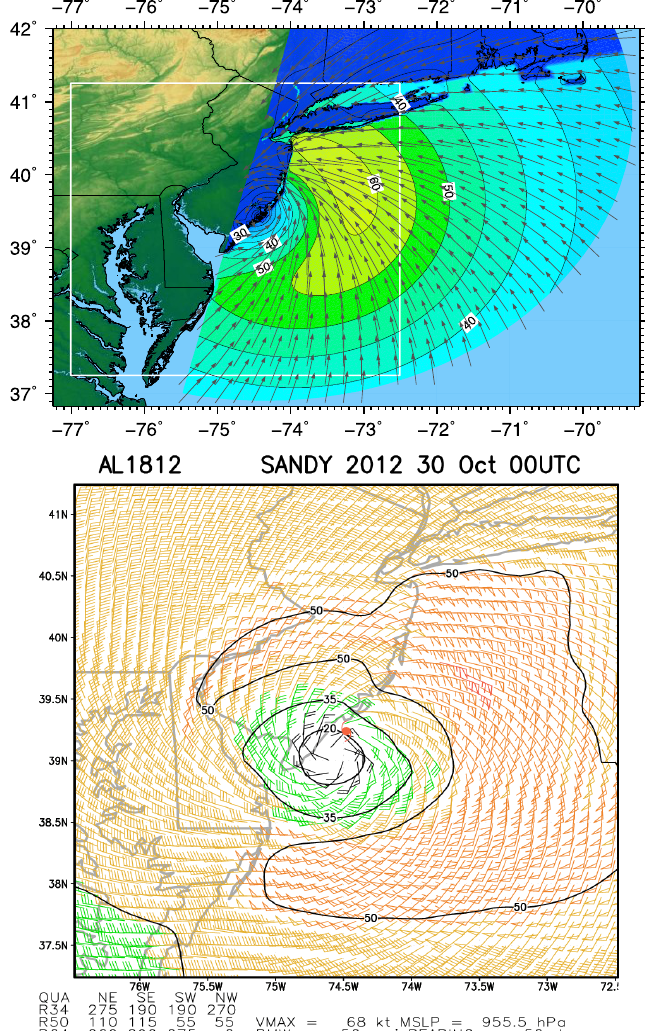
Figure 20. Comparison of wind speeds from ( a ) the SLOSH parametric wind model and ( b ) the multi-platform surface wind analysis (courtesy of NOAA/NESDIS and CSU/CIRA/RAMMB). The white square in panel ( a ) depicts the area where the